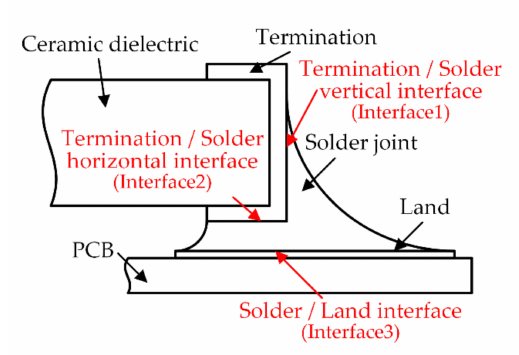
Figure 7. Position of a bi-material